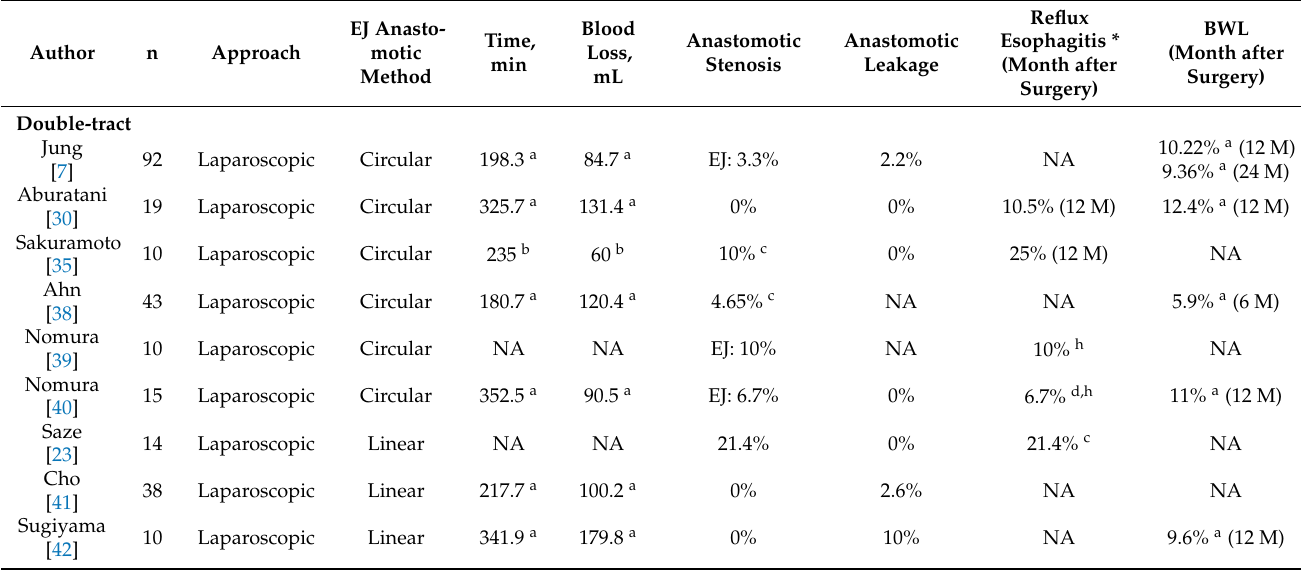
Table 3. Summary of LPG-DT and JI